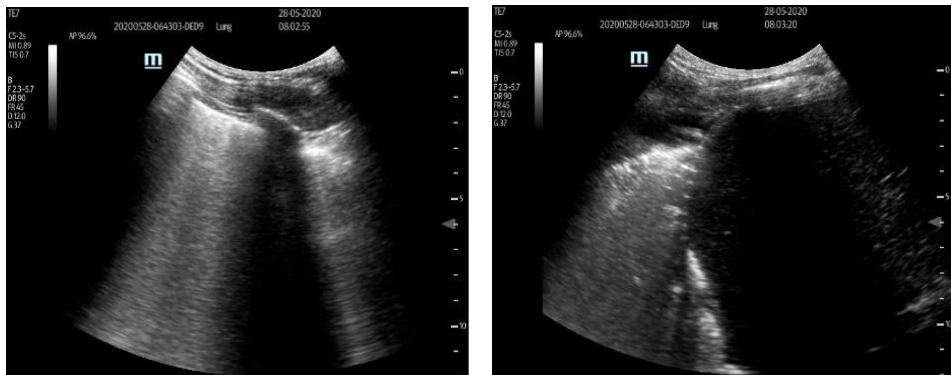
Figure 2. Ultrasound scoring system used to evaluate loss of aeration. On left side ultrasound score 2 showing severe loss of lung aeration with more than five B lines. On right side ultrasound score 3 showing lung consolidations.